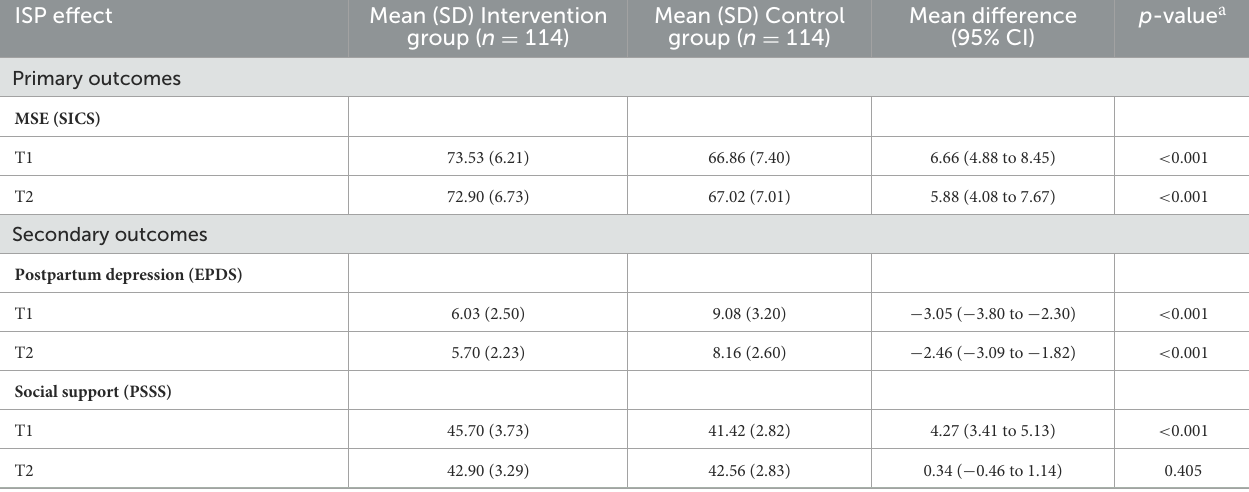
TABLE 2 Effect of ISP on outcomes of parenting, mental health, and social support at T1 and T2. ISP